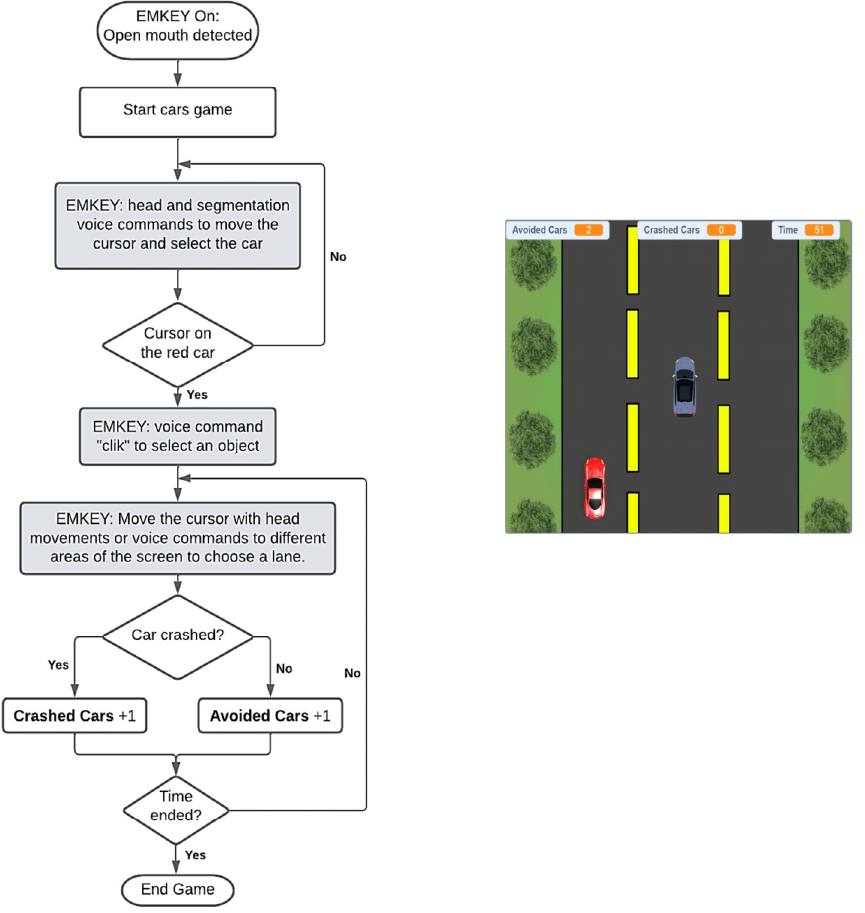
Figure 5. Car crashing game flowchart and interface.